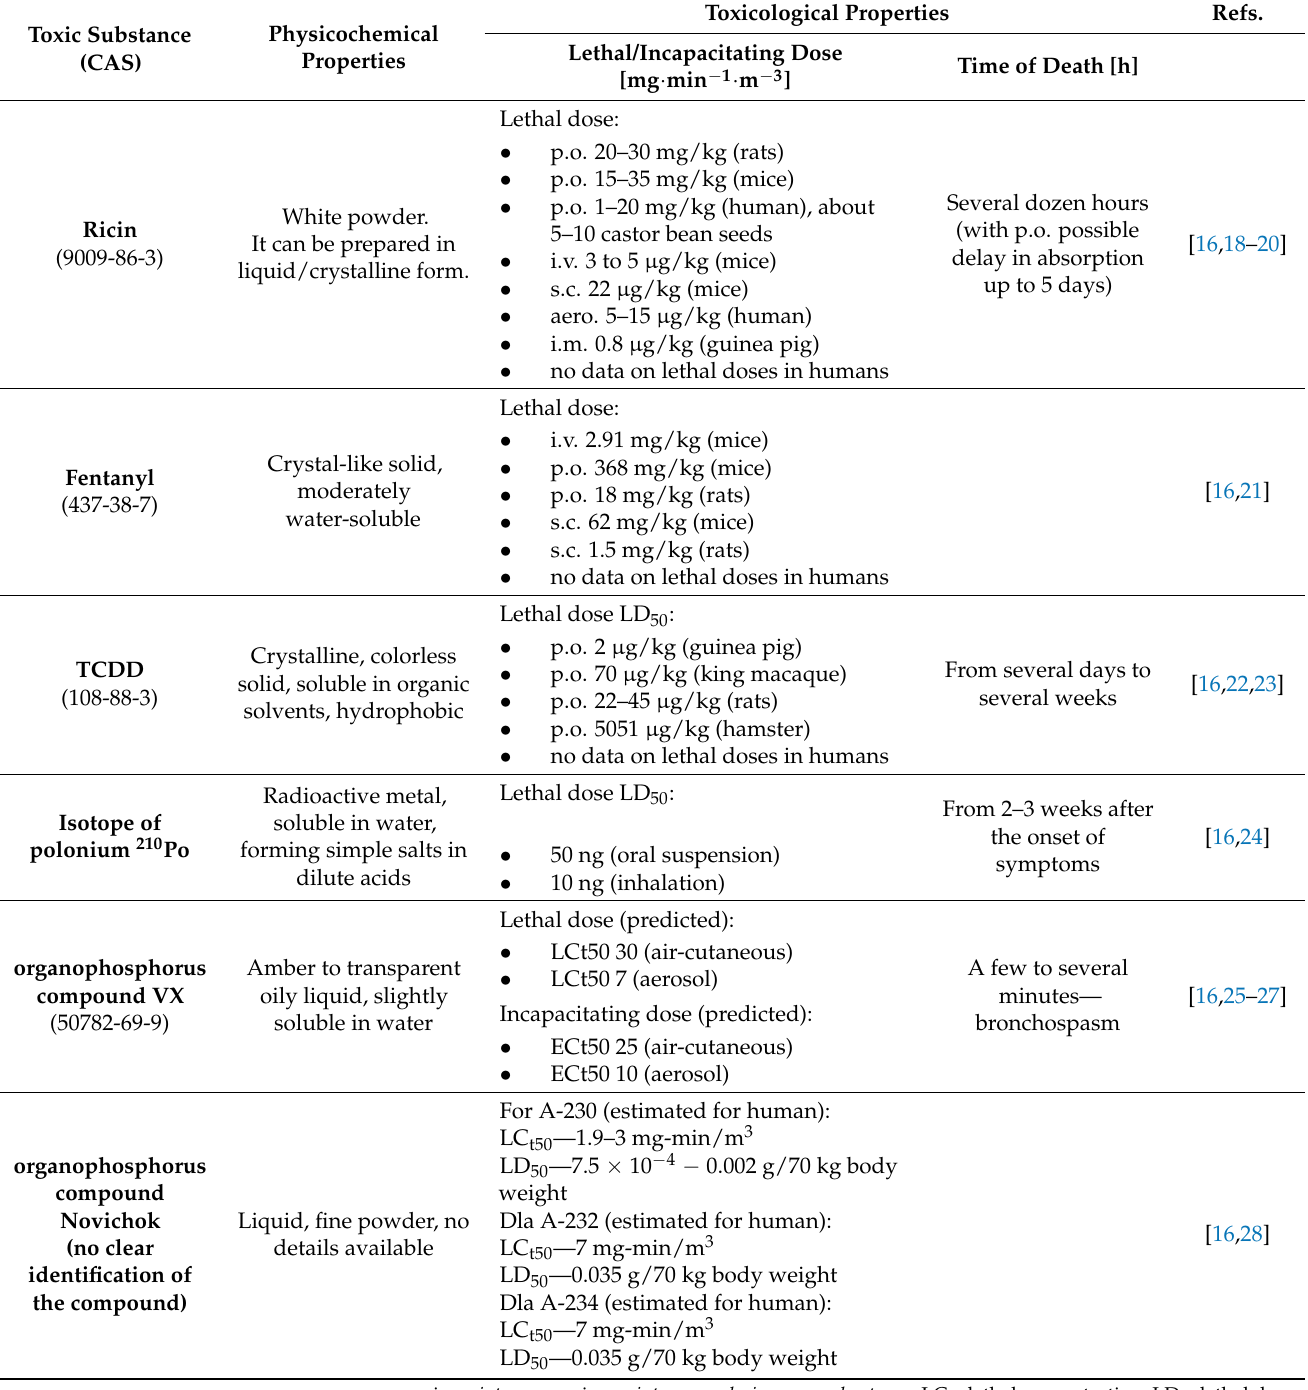
Table 3. Selected poisonous substances used for criminal purposes in the years 1978–2020 on a political background, their physicochemical and toxicological